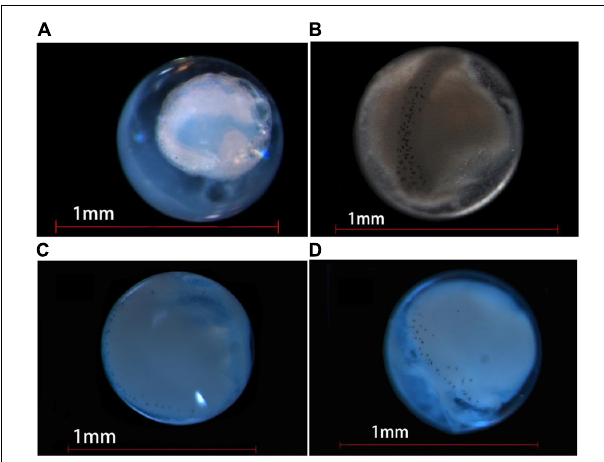
FIGURE 6 | Photographs of eggs of four Decapterus species delimited by COI. (A) D. maruadsi , (B) D. macrosoma , (C) D. macarellus , and (D) D. tabl .